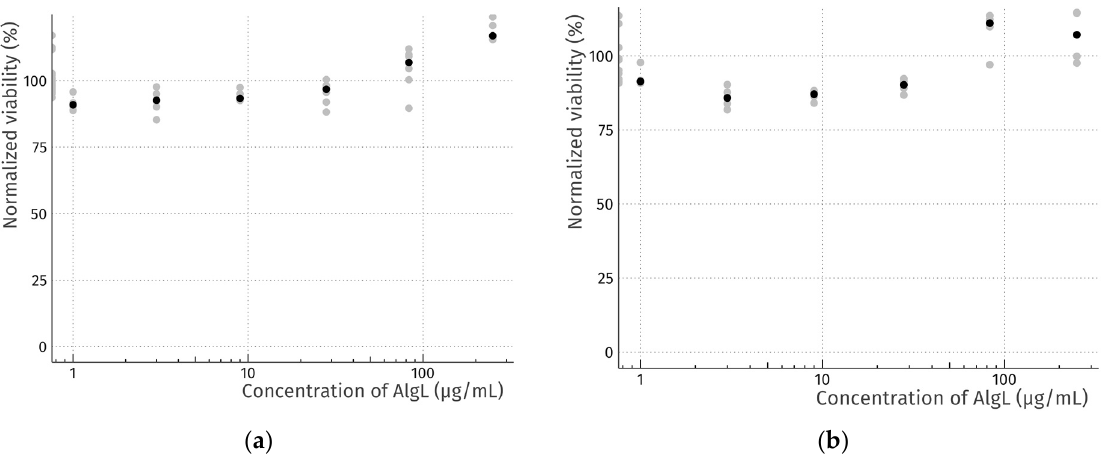
Figure 3. Cell viability of L929 murine fibroblasts exposed to a range of concentrations of recombinant AlgL for 24 h ( a ) and 48 h ( b ). Data were normalised to vehicle control (PBS). Grey dots represent technical replicates, and black dots indicate medians.